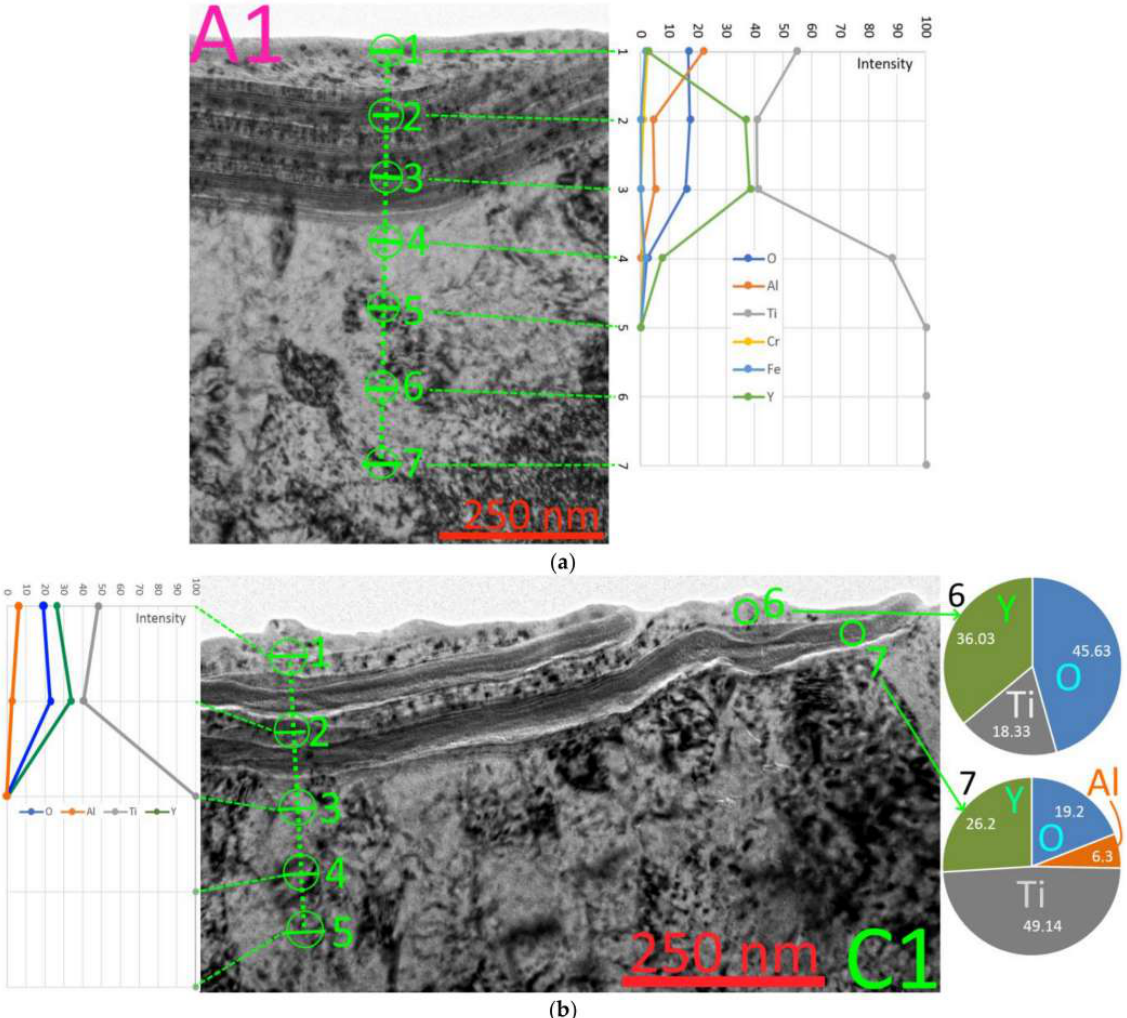
Figure 7. Analysis of the distribution of elements in the outer layers of the worn coating. ( a ) Area A1, ( b ) Area C1. The localization of Areas A1 and C1 is exhibited in Figure 6